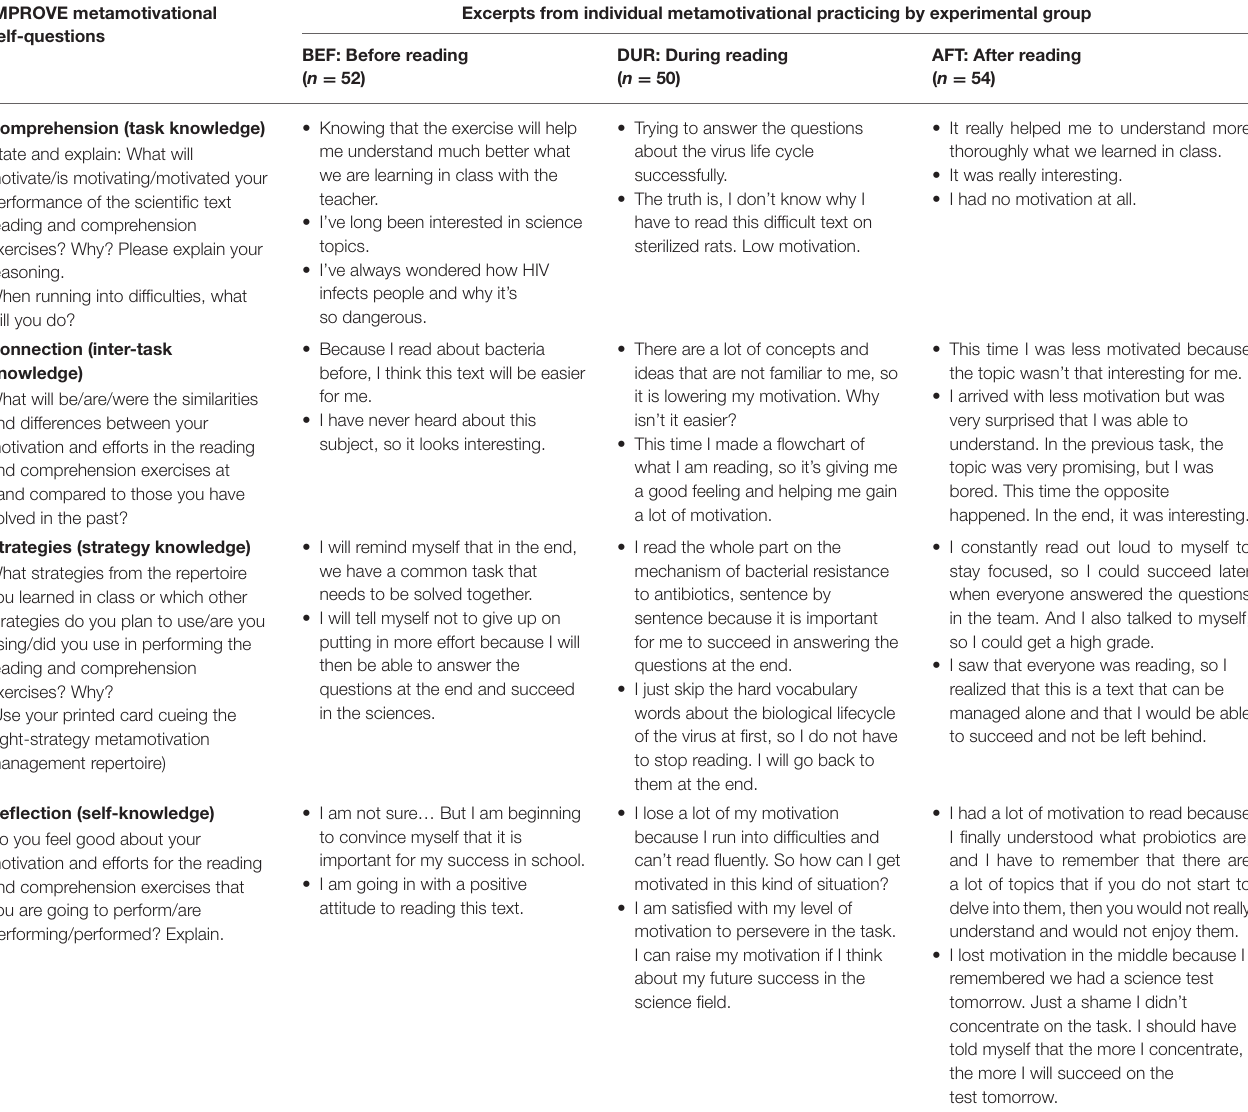
TABLE 2 | IMPROVE metamotivational self-questions, with sample excerpts from individual phase of student training lessons, by treatment group. IMPROVE metamotivational